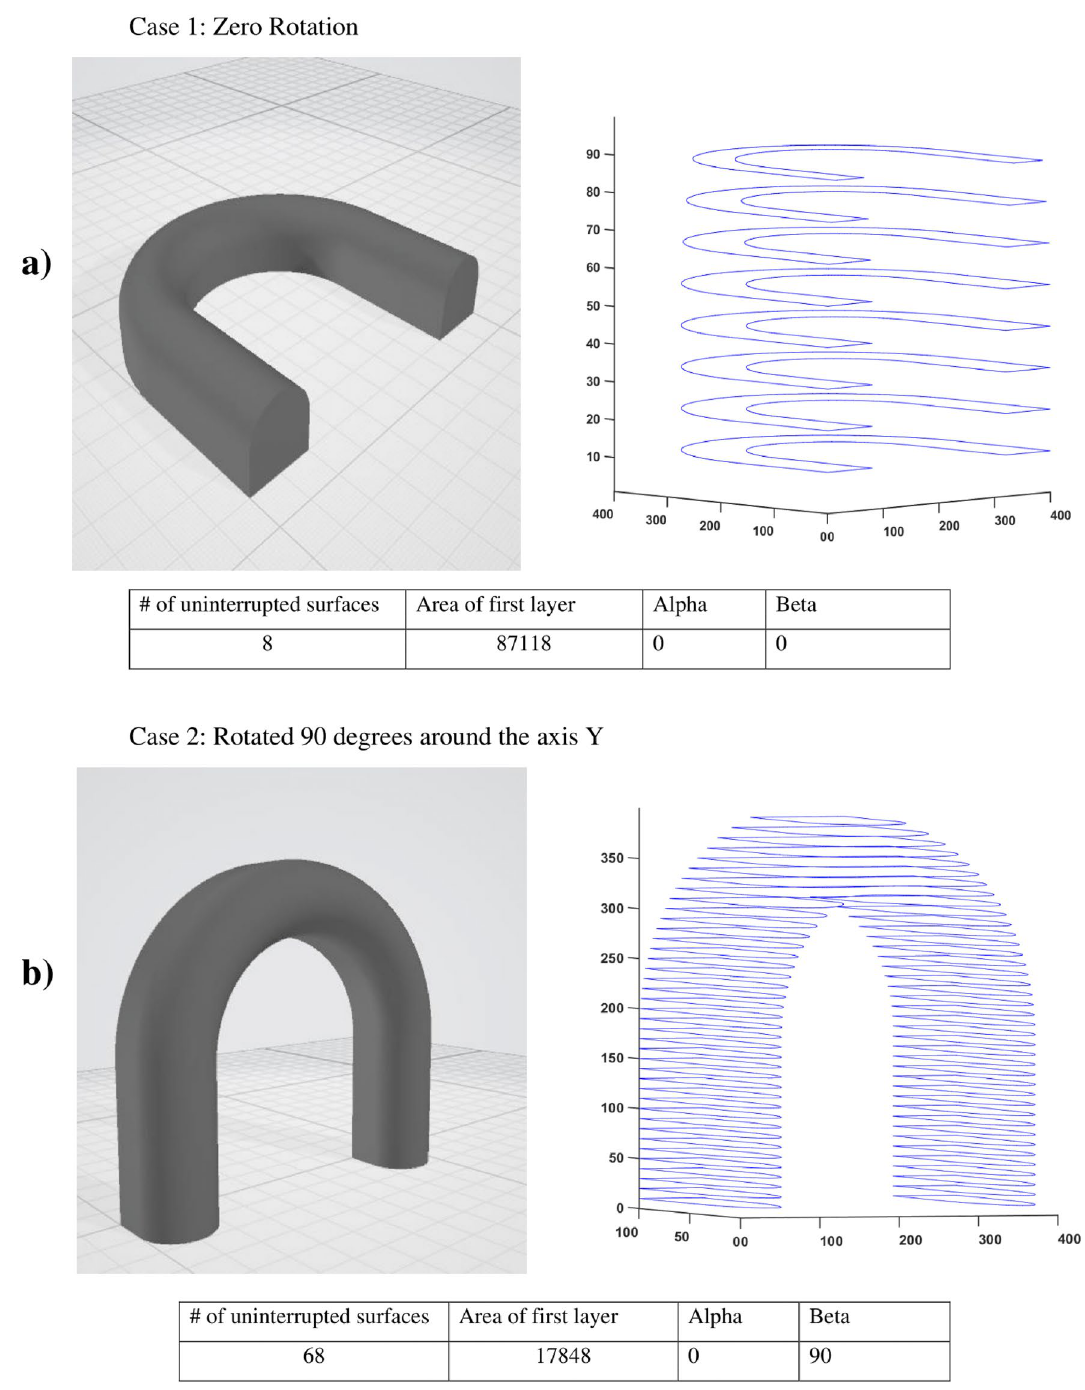
Figure 6. Representation of slices of a 3D object ( a ) laid, and ( b )